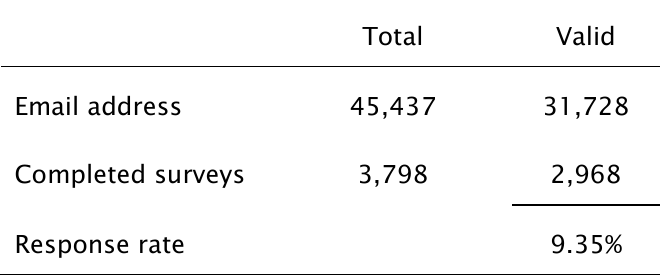
Valid Response Rate for Canadian APIKS